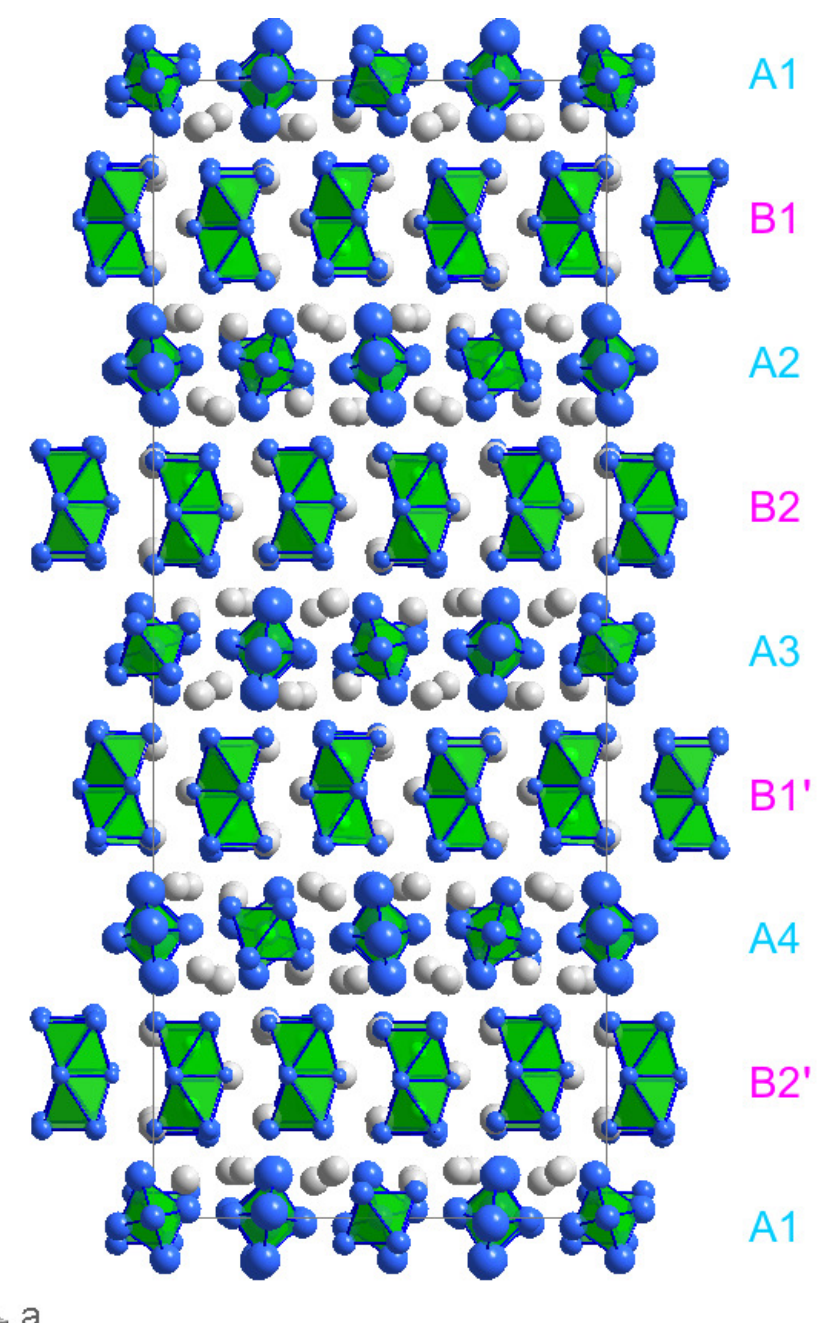
Figure 4. Representation of the crystal structure of Ba 26 Ru 12 O 57 as obtained from refinements with space group Fdd2 . Green/white spheres: Ru-/Ba-ions, blue spheres: 99.9% probability ellipsoids for the oxygen